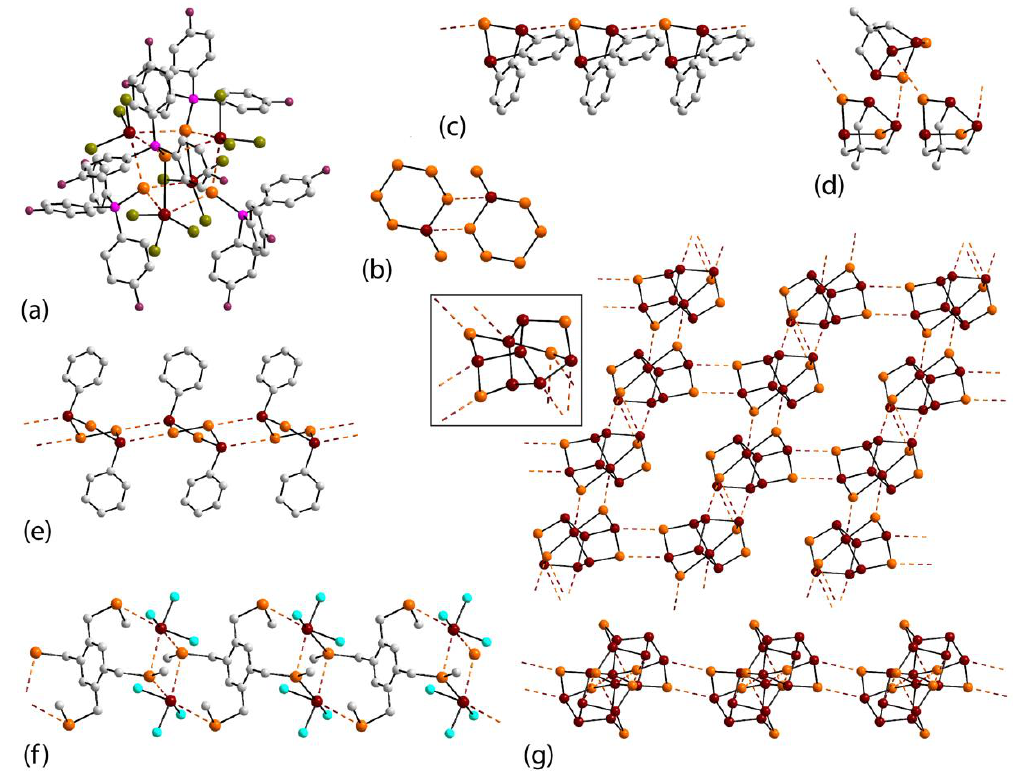
Figure 7. Supramolecular aggregation via As … Se secondary bonding in (a) 21 {GEXSOT; d(As … Se) = 3.37 Å }, (b) 22 {NEKJIW; 3.48 Å }, (c) 23 {ESEARS; 3.63 Å }, (d) 24 {COSDIX; 3.64 Å }, (e) 25 {SEDMAP; 3.53 Å }, (f) 26 {WAMCOE; 3.29, 3.42 & 3.60 Å }, and (g) 27 {KAXXUC; 3.60, 3.61, 3.64 & 3.72 Å }. Additional color code: bromide, olive-green.